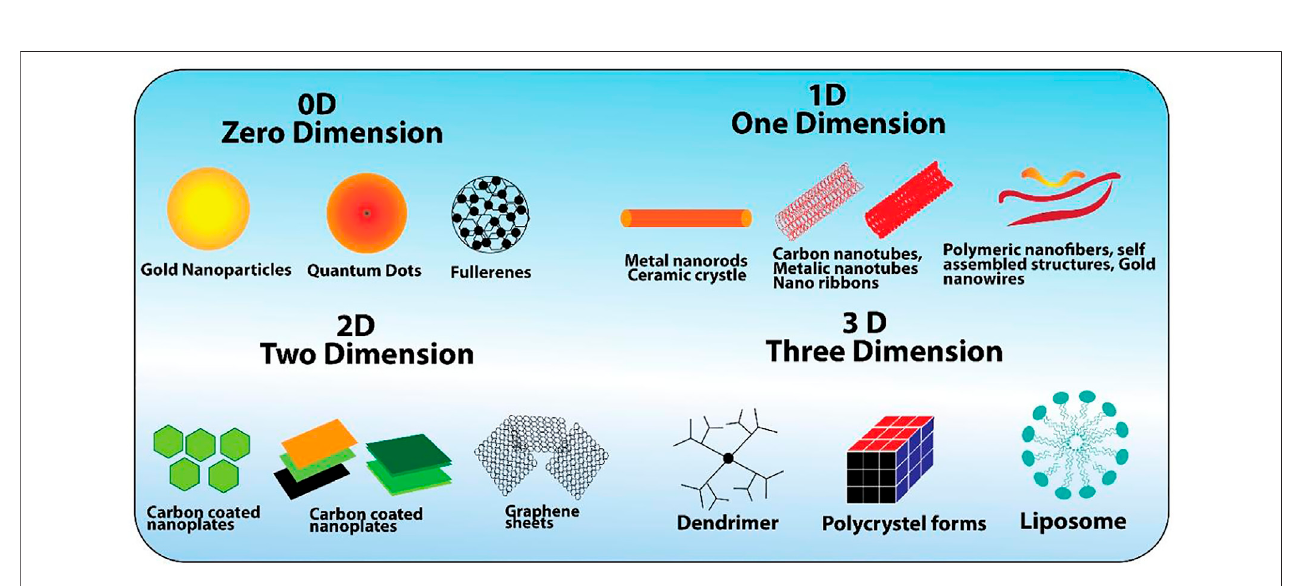
FIGURE 4 | Classi fi cation of nanomaterials on the base of size and shape.